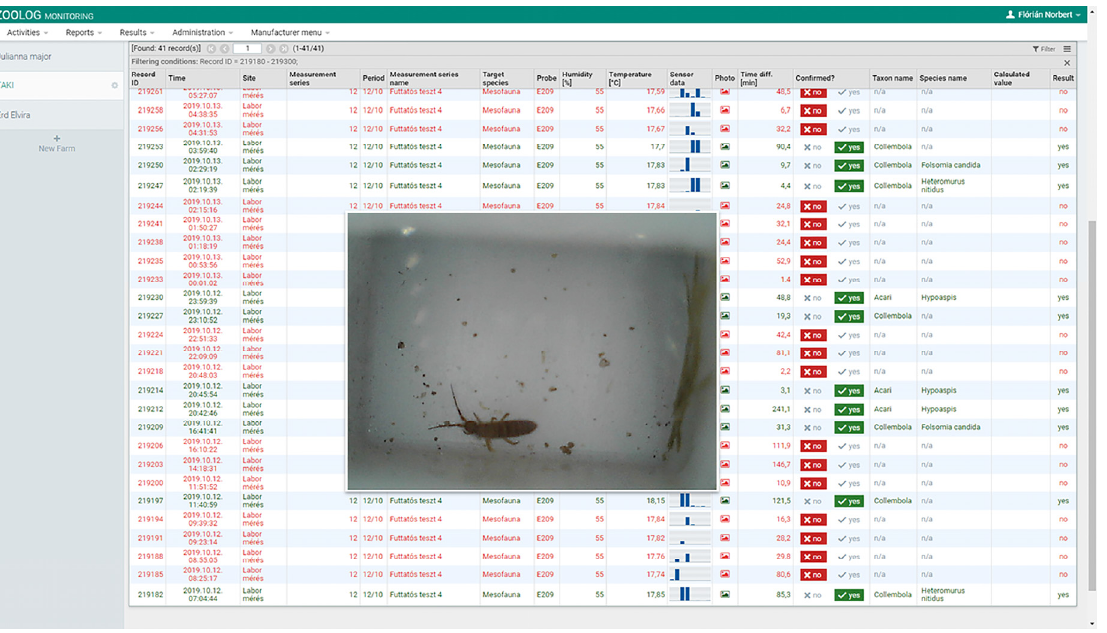
8 of 12 Table 1. Results of the accuracy of the desktop model. Results of the three species cultured in the laboratory are reported according to their body sizes; numbers of specimens are in brackets. Detection accuracy is defined as the mean of the number of detected specimens compared to the total specimens dropped into the probe. “Appears in the camera chamber” indicates the percent of the specimens entered into the camera chamber compared to the total number of specimens. In the next second two columns, percentages of the specimens vacuumed out and seen in the pictures are given compared to the number of detected specimens. The last column shows the percentage of the individuals which fulfilled the whole process. Microarthropod species 100% = total specimens 100% = detected specimens The whole process is perfect Detection accuracy